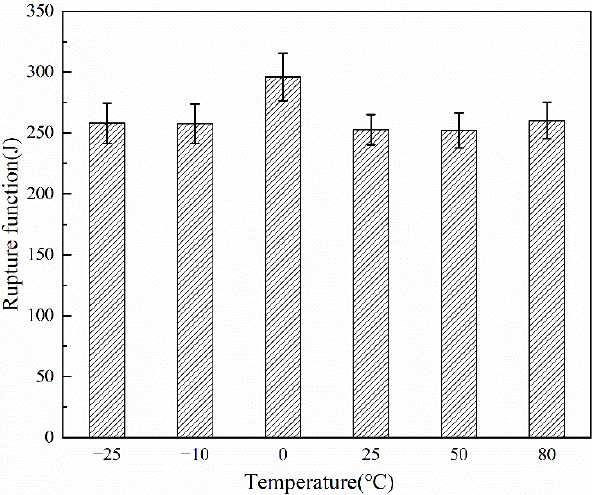
Figure 11. Fracture work of the PCTF at different temperatures.